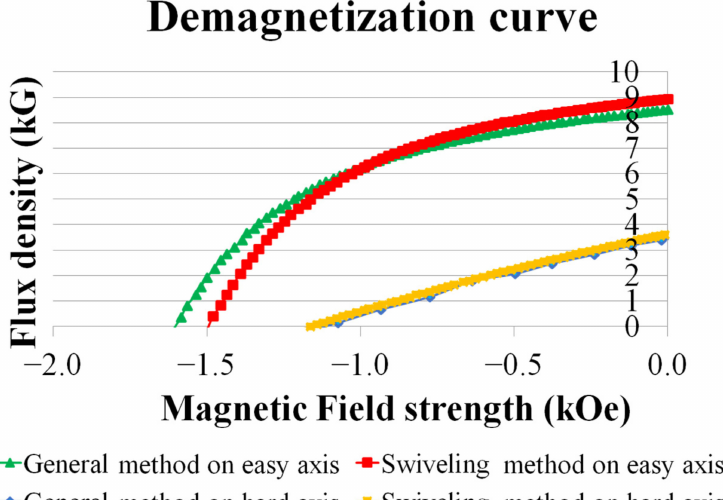
Figure 6. ( a ) Initial magnetization curve on the easy axis, and ( b ) initial magnetization curve on the hard axis.